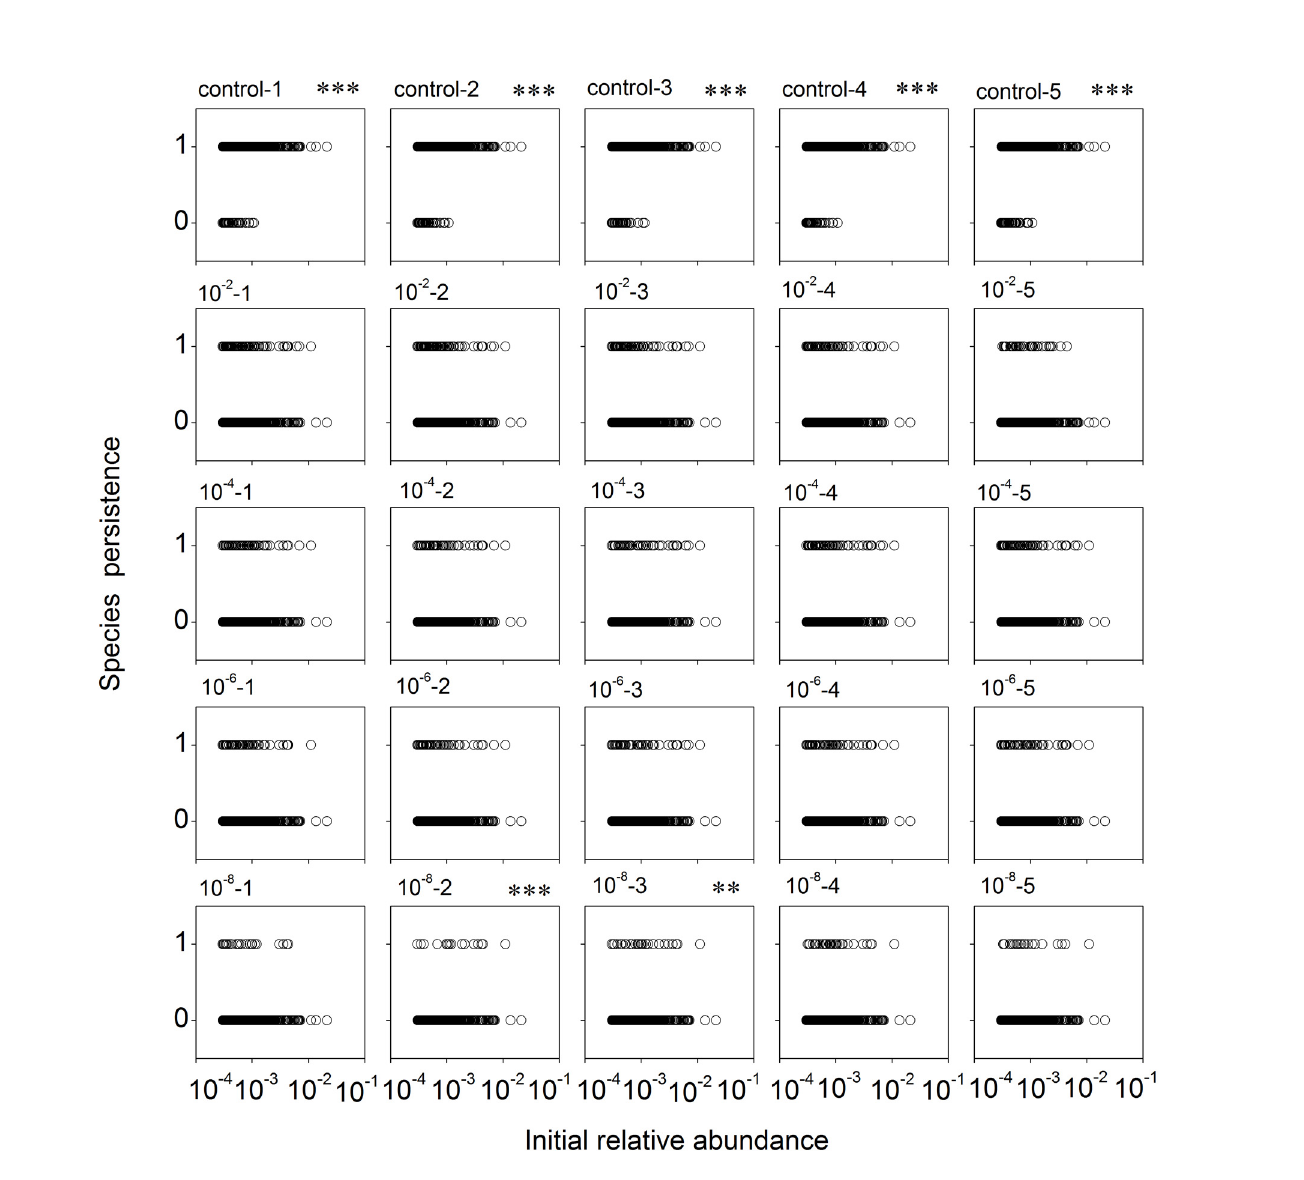
Fig 3. Persistence of species in each grassland soil microcosm as a function of initial abundances. Symbols as in Fig